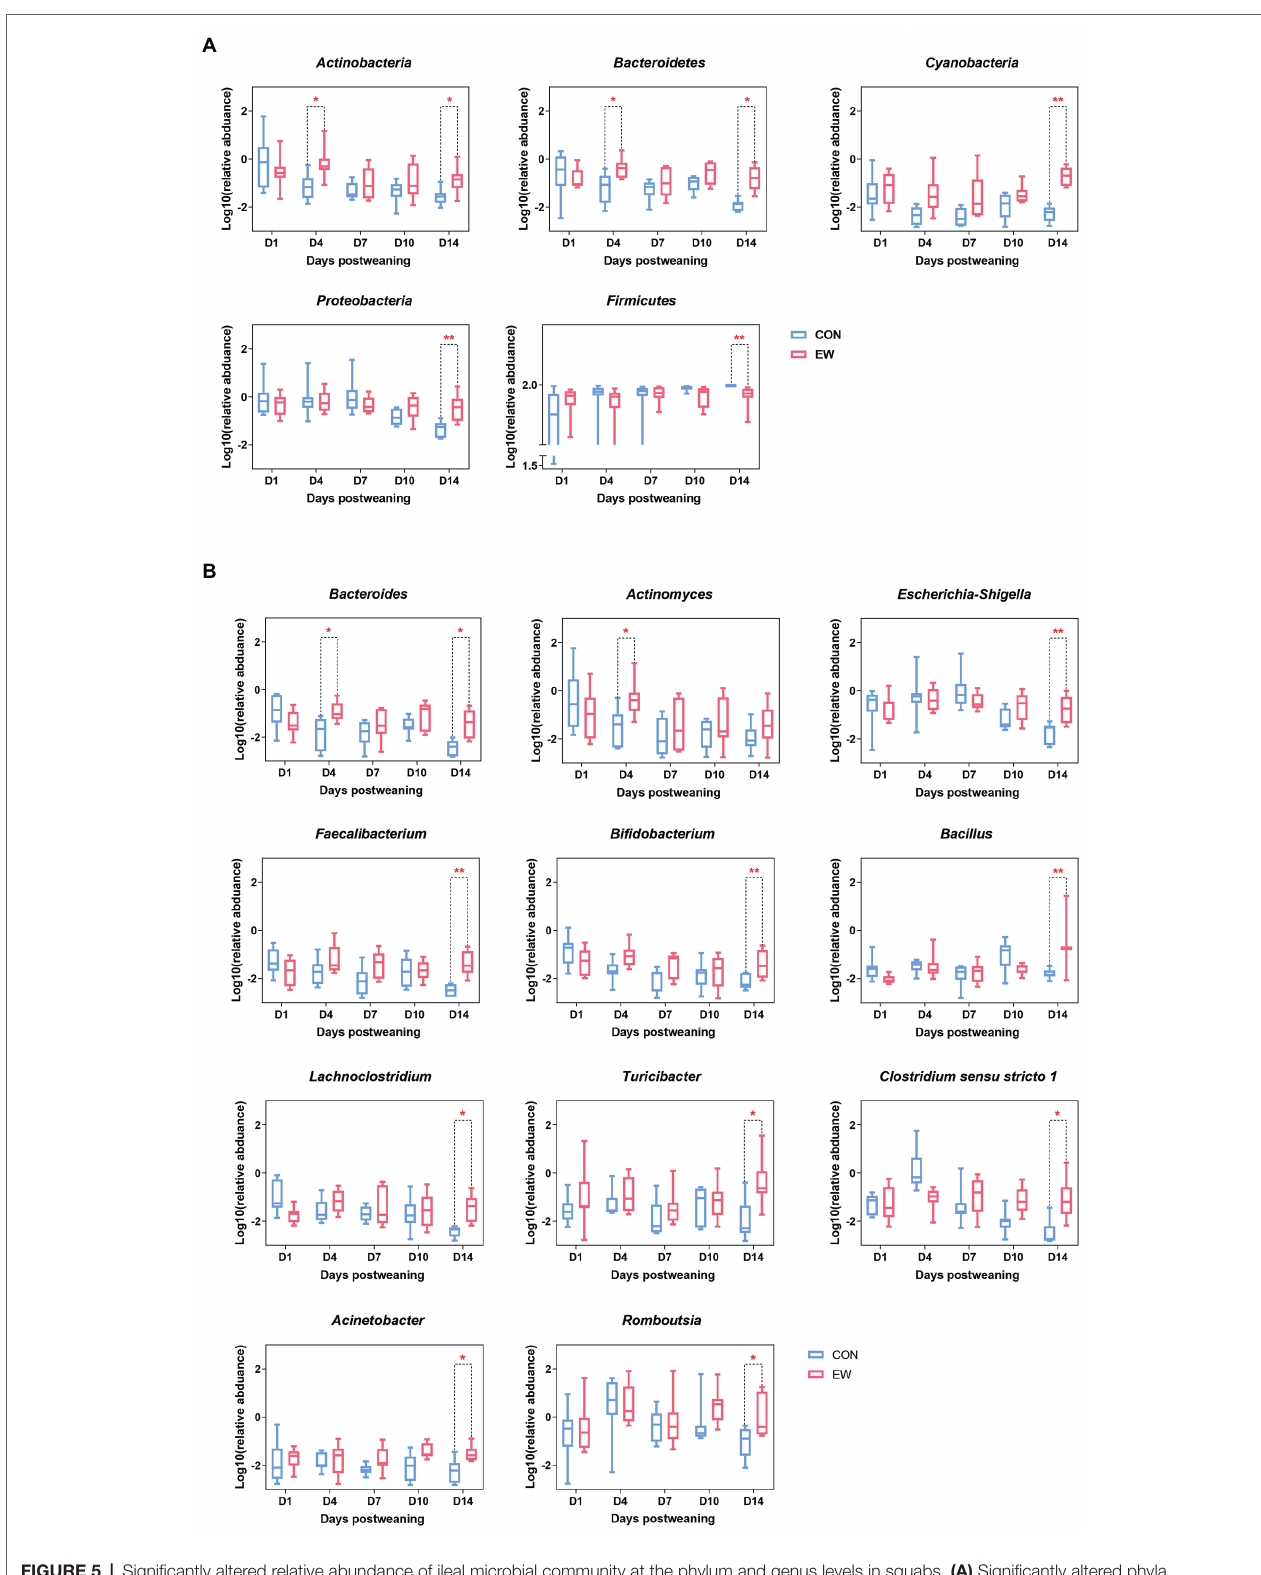
FIGURE 5 | Significantly altered relative abundance of ileal microbial community at the phylum and genus levels in squabs. (A) Significantly altered phyla. (B) Significantly altered genera. D1, D4, D7, D10, and D14 means 1, 4, 7, 10, and 14 days postweaning, respectively. Values are means with their standard errors of eight squabs. * and ** mean p < 0.05 and p < 0.01, respectively, within each time points postweaning. CON, control group; EW, early weaning